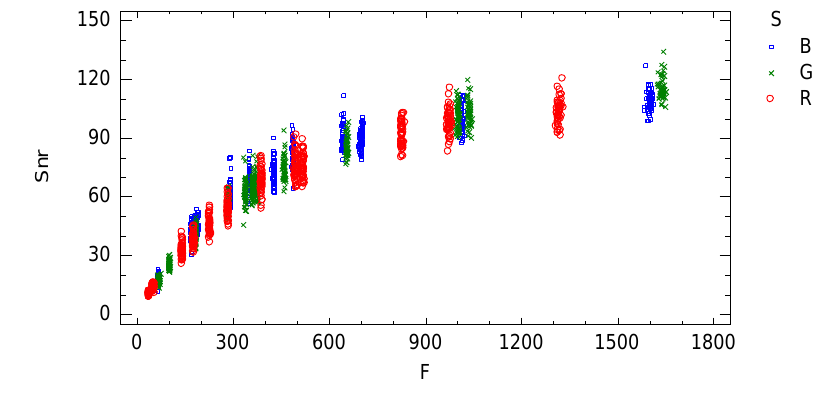
Figure 10. Signal to noise ratio for the three level of the wavelength factor: R (red color), G (green color) and B (blue